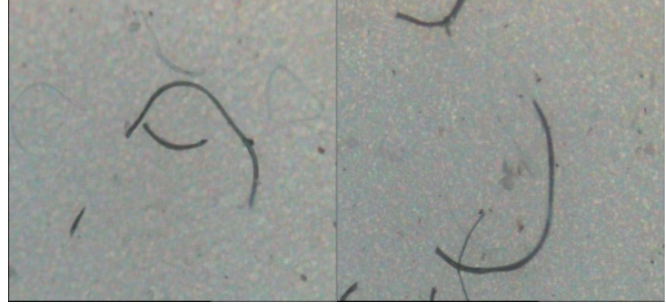
Figure 9. Fibers released from knitted fabrics.